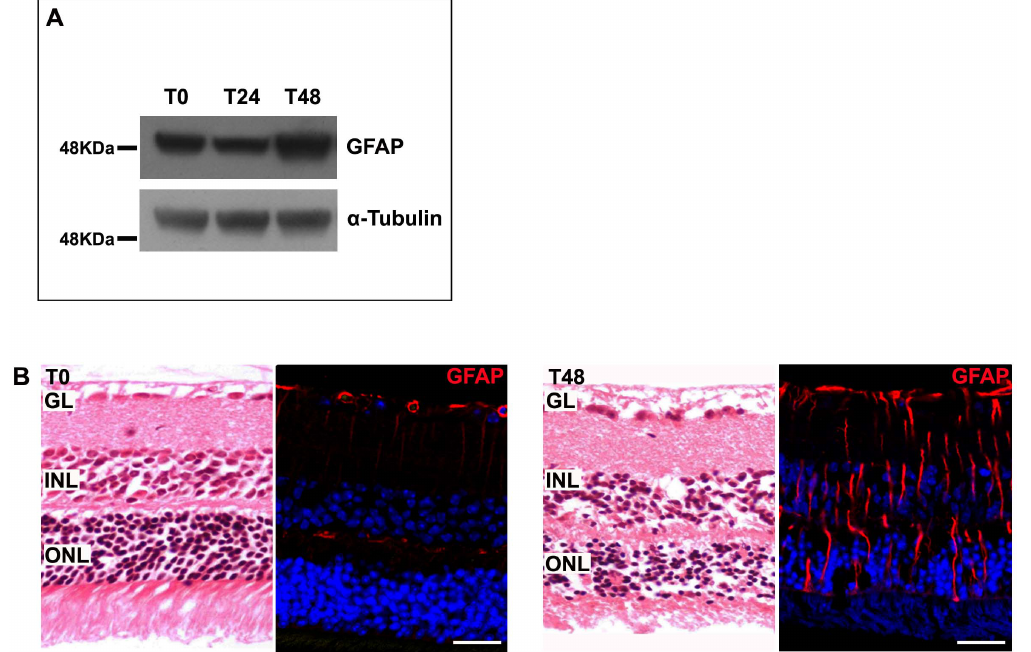
Figure 9. Murine model of retinopathy with photoreceptor degeneration. A: Forty-eight hours after sodium iodate injection, retinas analyzed by western blotting showed an increased expression of GFAP. a -tubulin was used as a loading control. B: Paraffin-embedded retinal sections stained with hematoxylin-eosin or immunolabeled with a specific anti-GFAP antibody revealed photoreceptor alterations and gliosis, indicating that retinopathy was well established. Nuclei were counterstained with ToPro3. GL, ganglion cell layer; INL, inner nuclear layer; ONL, outer nuclear layer. Scale bar: 35 m m. photoreceptor inner segments. L-ferritin expression followed the distribution pattern of Scara5 (Figure 5D).